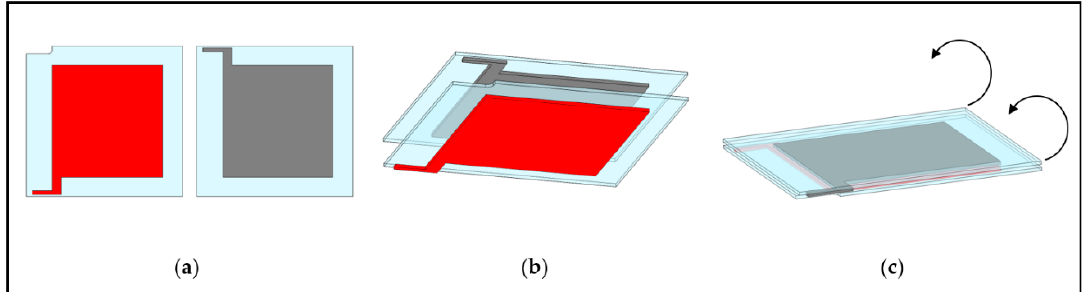
Figure 2. Schematic of films with a printed electrode ( a ) the layering topology ( b ) and the final stack with the rolling direction ( c ). One of the electrodes is depicted in red for illustrative purposes. Note the cut corner on the lower film, which allows for electrically contacting the upper film, and the L ‐ shaped contacts.